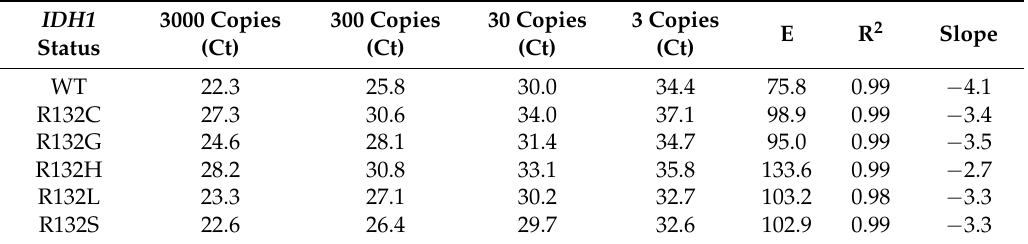
Table 1. Mean threshold cycle (Ct) obtained with different concentration of plasmids for the IDH1 R132x mutations and wild-type (WT).